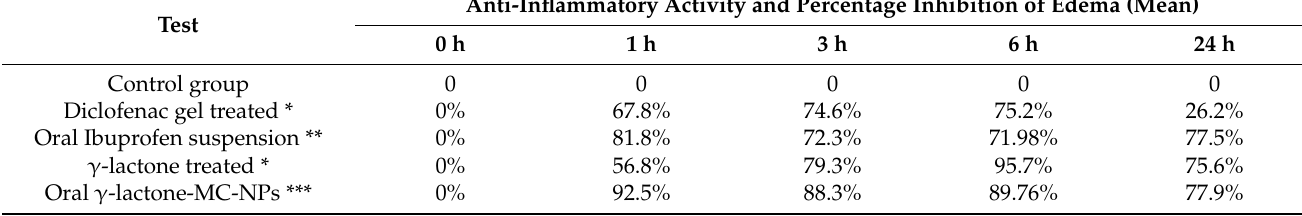
Table 1. The anti-inflammatory activity of the γ -lactone-1 compared to that of the reference diclofenac gel expressed as percent inhibition of edema ( n = 30) (Raw data available in the Tables S2–S4 in Supplementary File). Anti-Inflammatory Activity and Percentage Inhibition of Edema Test